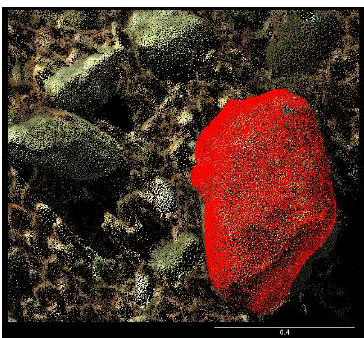
Figure 11 Position of point clouds after ICP registration – aligned point